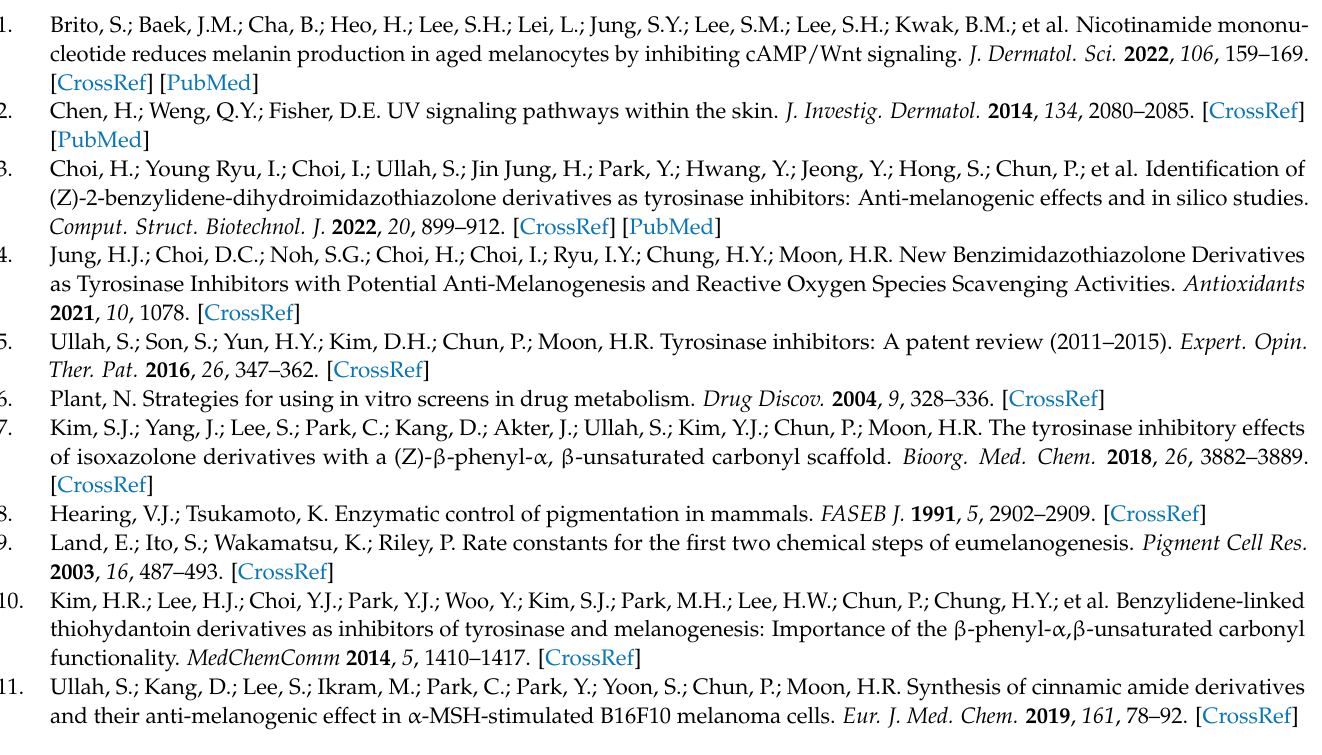
1 ; Figure S2: 13 C NMR spectrum of compound 1 ; Figure S3: 1 H NMR spectrum of compound 2 ; Figure S4: 13 C NMR spectrum of compound 2 ; Figure S5: 1 H NMR spectrum of compound 3 ; Figure S6: 13 C NMR spectrum of compound 3 ; Figure S7: Proton-coupled 13 C NMR spectrum of compound 3 ; Figure S8: 1 H NMR spectrum of compound 4 ; Figure S9: 13 C NMR spectrum of compound 4 ; Figure S10: 1 H NMR spectrum of compound 5 ; Figure S11: 13 C NMR spectrum of compound 5 ; Figure S12: 1 H NMR spectrum of compound 6 ; Figure S13: 13 C NMR spectrum of compound 6 ; Figure S14: 1 H NMR spectrum of compound 7 ; Figure S15: 13 C NMR spectrum of compound 7 ; Figure S16: 1 H NMR spectrum of compound 8 ; Figure S17: 13 C NMR spectrum of compound 8 ; Figure S18: 1 H NMR spectrum of compound 9 ; Figure S19: 13 C NMR spectrum of compound 9 ; Figure S20: Proton-coupled 13 C NMR spectrum of analog 3